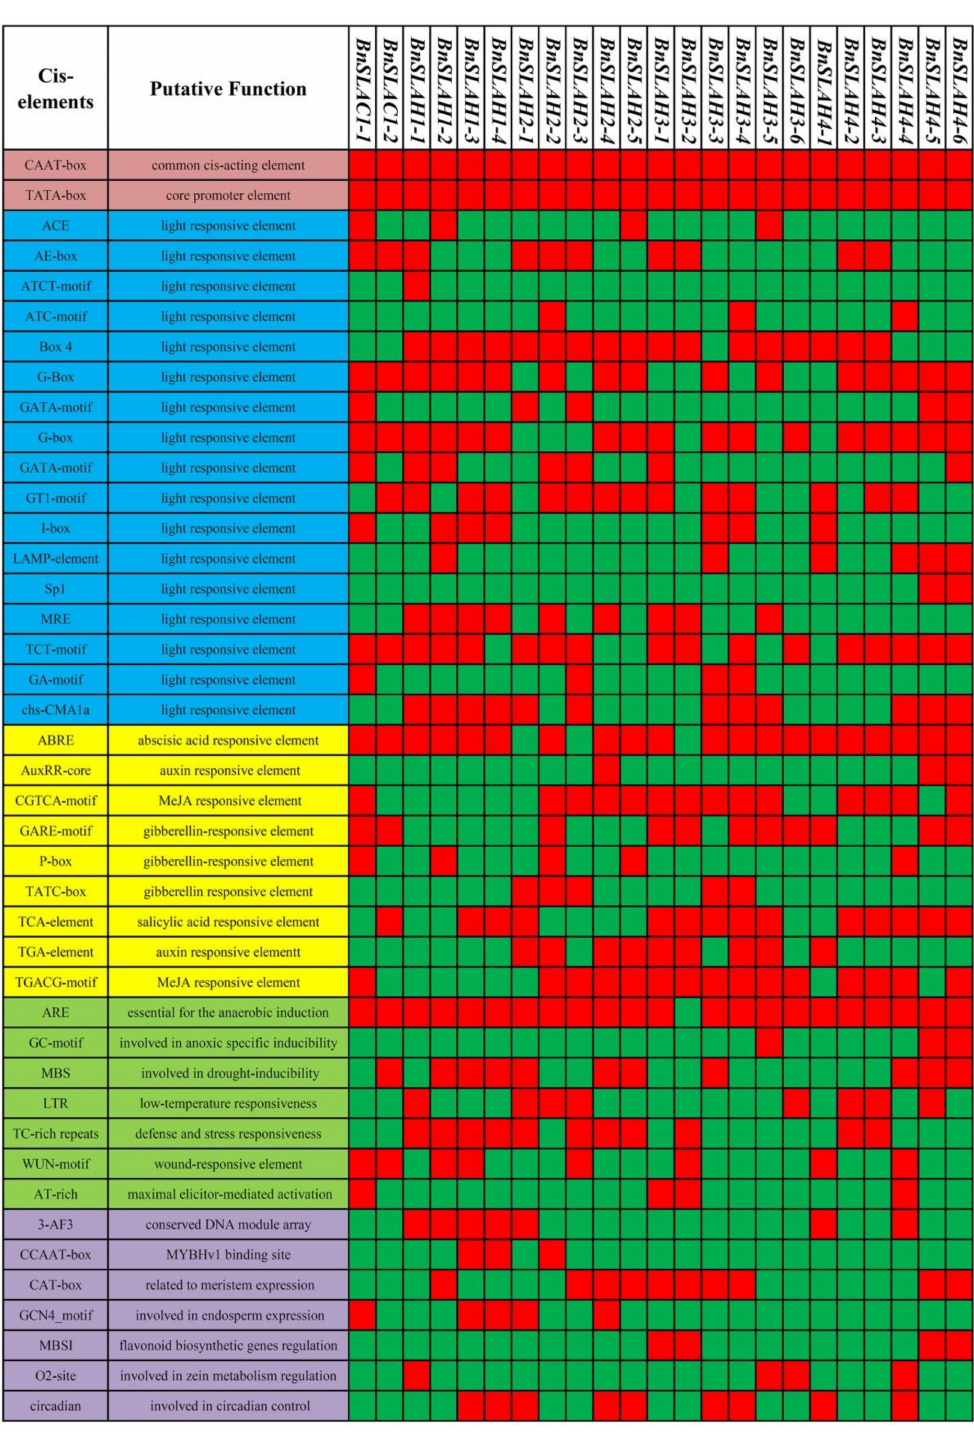
Figure 4. Cis-elements in the 2.0-kb upstream regions of the BnSLAC / SLAH family genes in B. napus . On the left, five different color (brown, blue, yellow, green and purple) represent various types of cis-elements, including core promoter elements, light responsive, phytohormone responsive, abiotic stress responsive and others related to growth. On the right, Red square shows the presence of cis-element while the green indicates the absence of